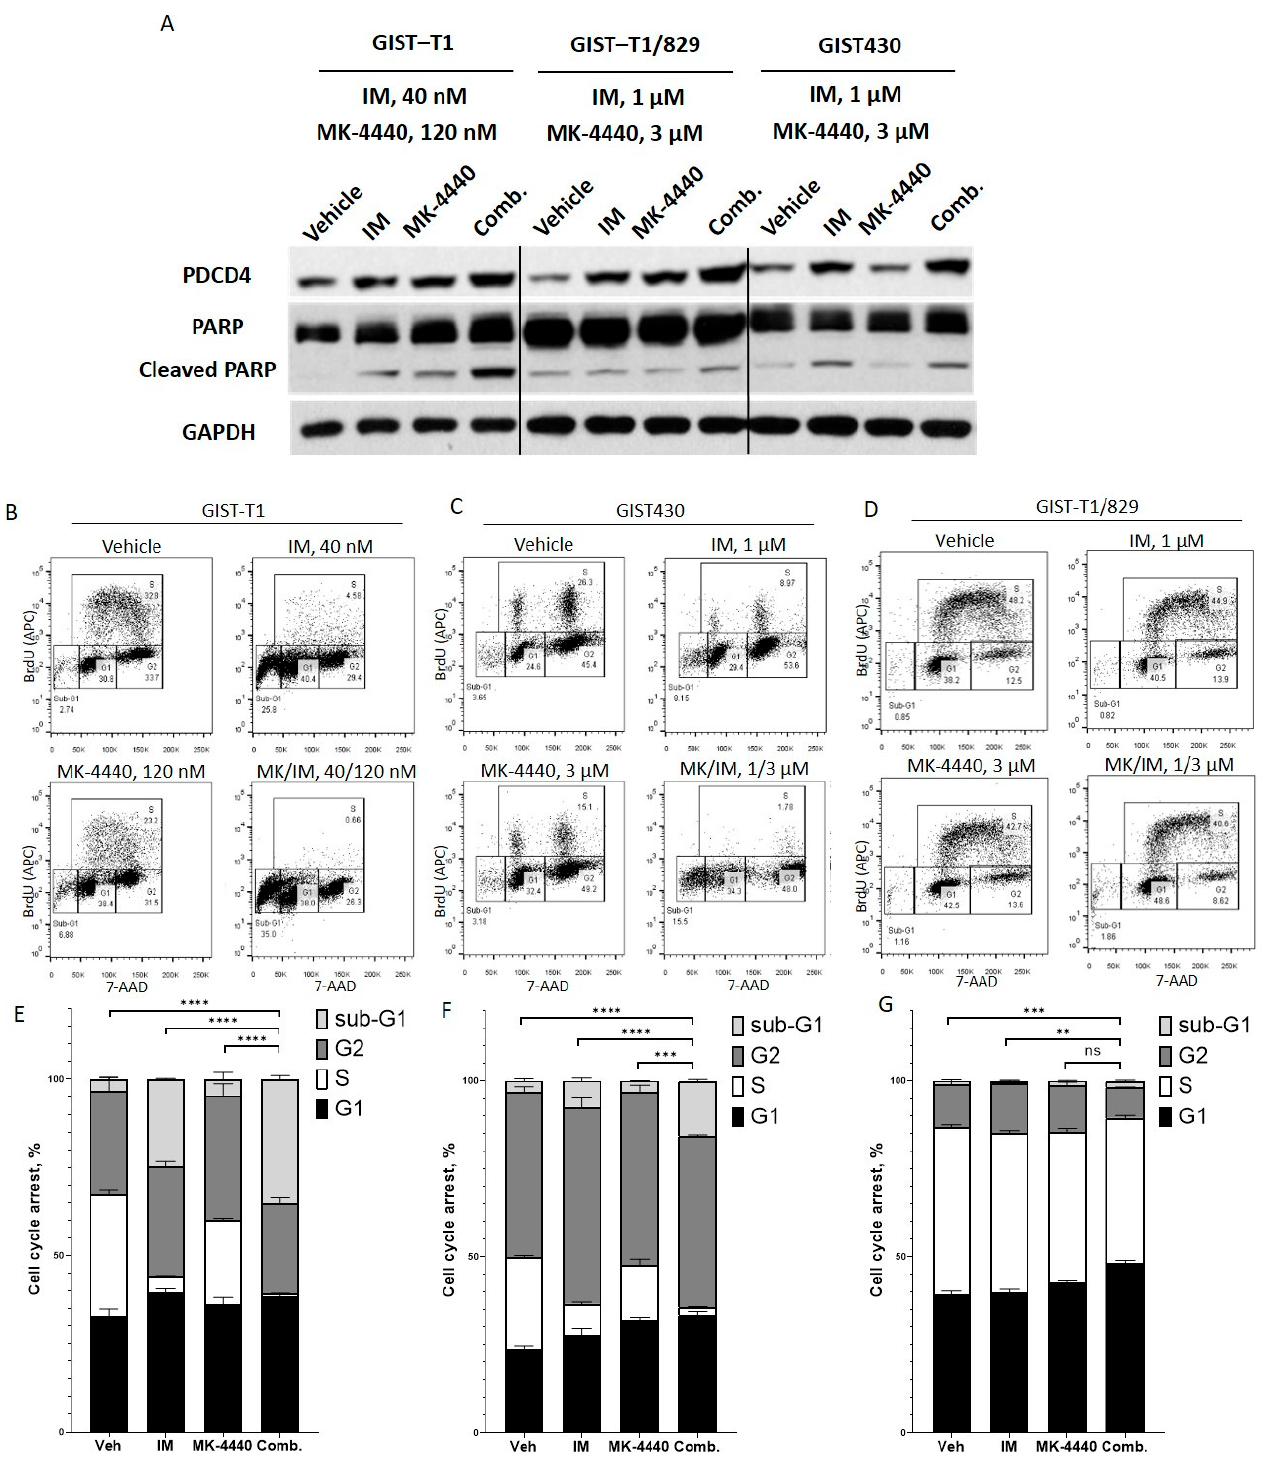
Figure 4. IM and MK-4440 combination induces cell cycle arrest and apoptosis. Immunoblot assays of WCEs from GIST-T1 treated with 40 nM IM, 120 nM MK-4440 or the combination; and GIST-T1/829 and GIST430 treated with 1 µ M IM, 3 µ M MK-4440, or the combination. All treatments were 20 h in duration. Equal quantities of WCE from each sample